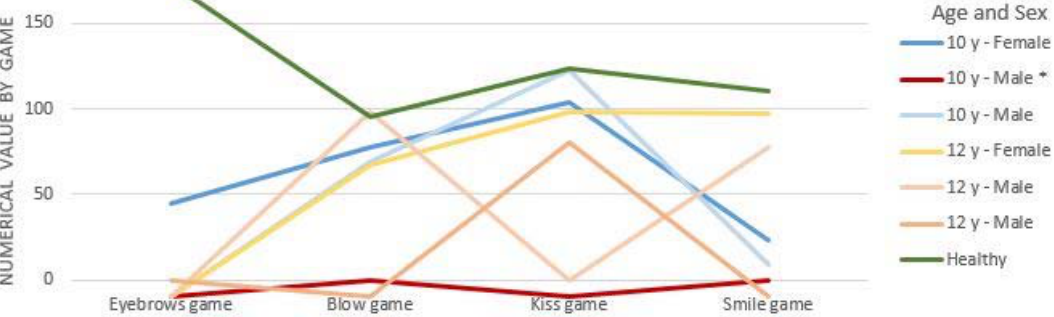
Figure 14. Comparative results obtained by children with CP (10–12 years) and healthy children.